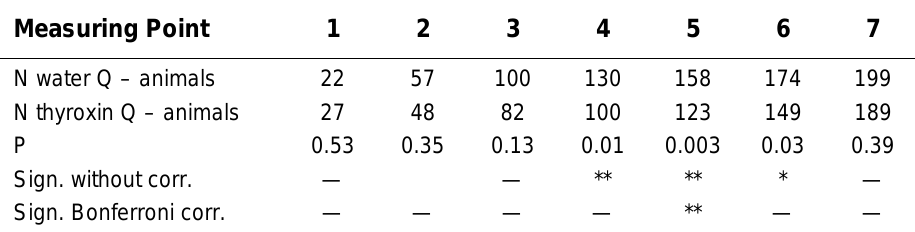
The Effect of Thyroxin 10 –11 – 10 –21